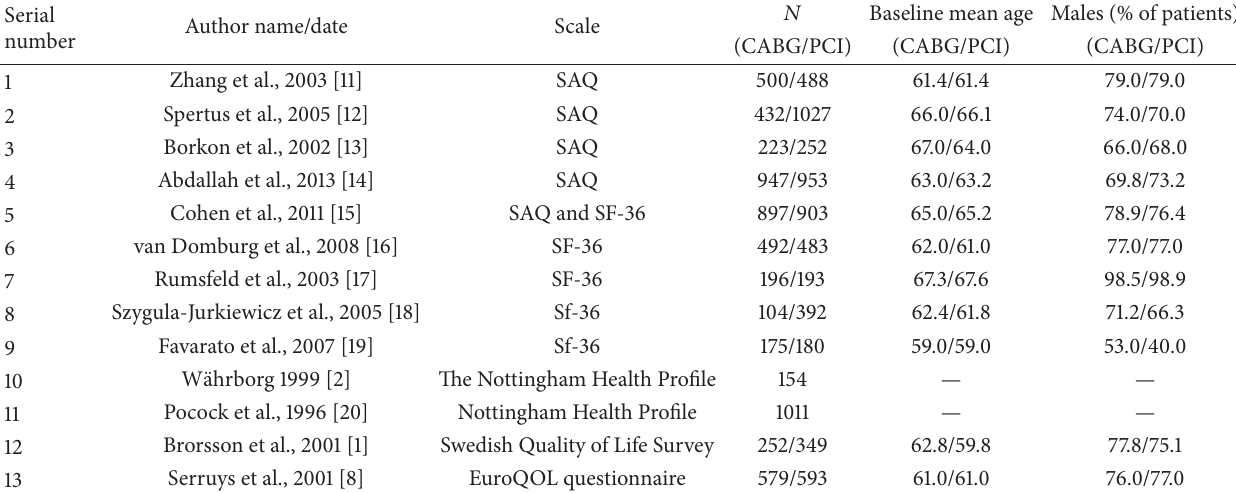
Table 1: Showing the studies included in the review.